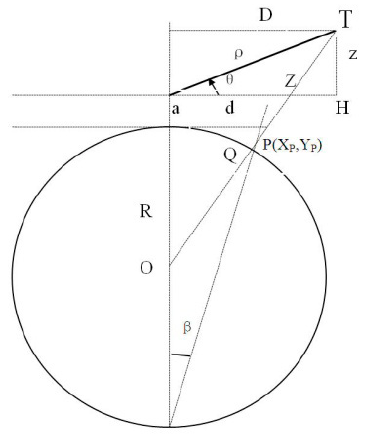
Figure 4. Target projection.